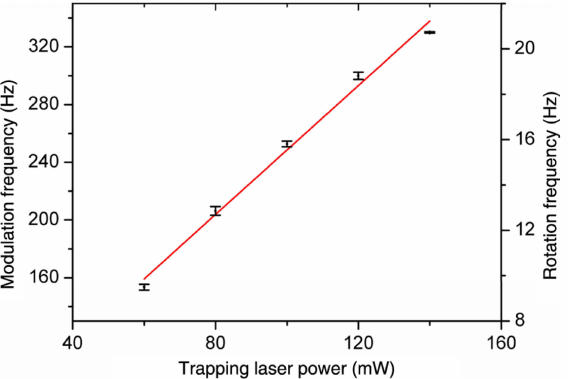
Figure 7. The beat frequency and calculated rotation frequency as a function of trapping laser power. Adapted with permission from ref.